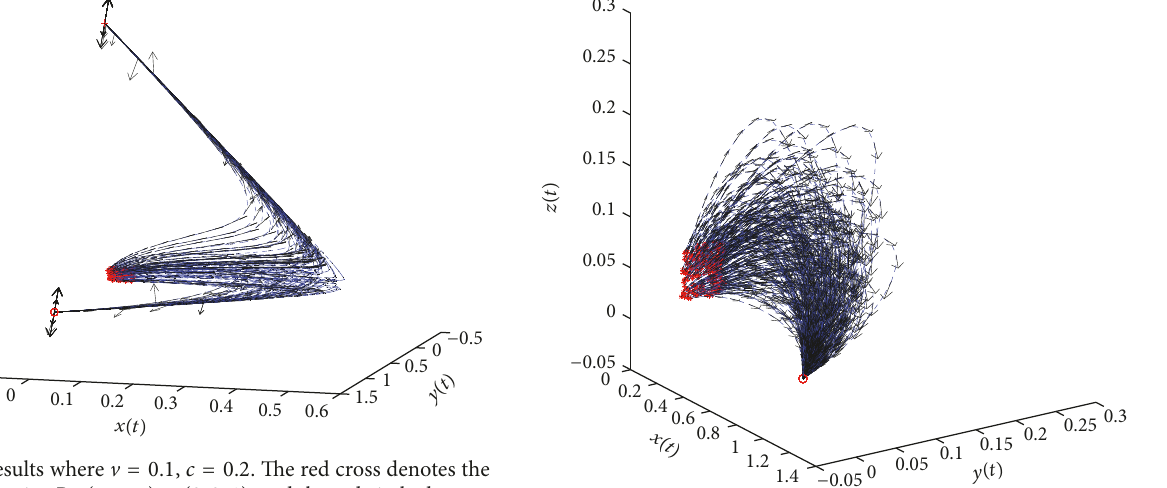
Figure 3: Results where V = 0.2 , 𝑐 = 0.1 . The red circle denotes the equilibrium point 𝑃 5 : (𝑥,𝑦,𝑧) = (1,0,0) .